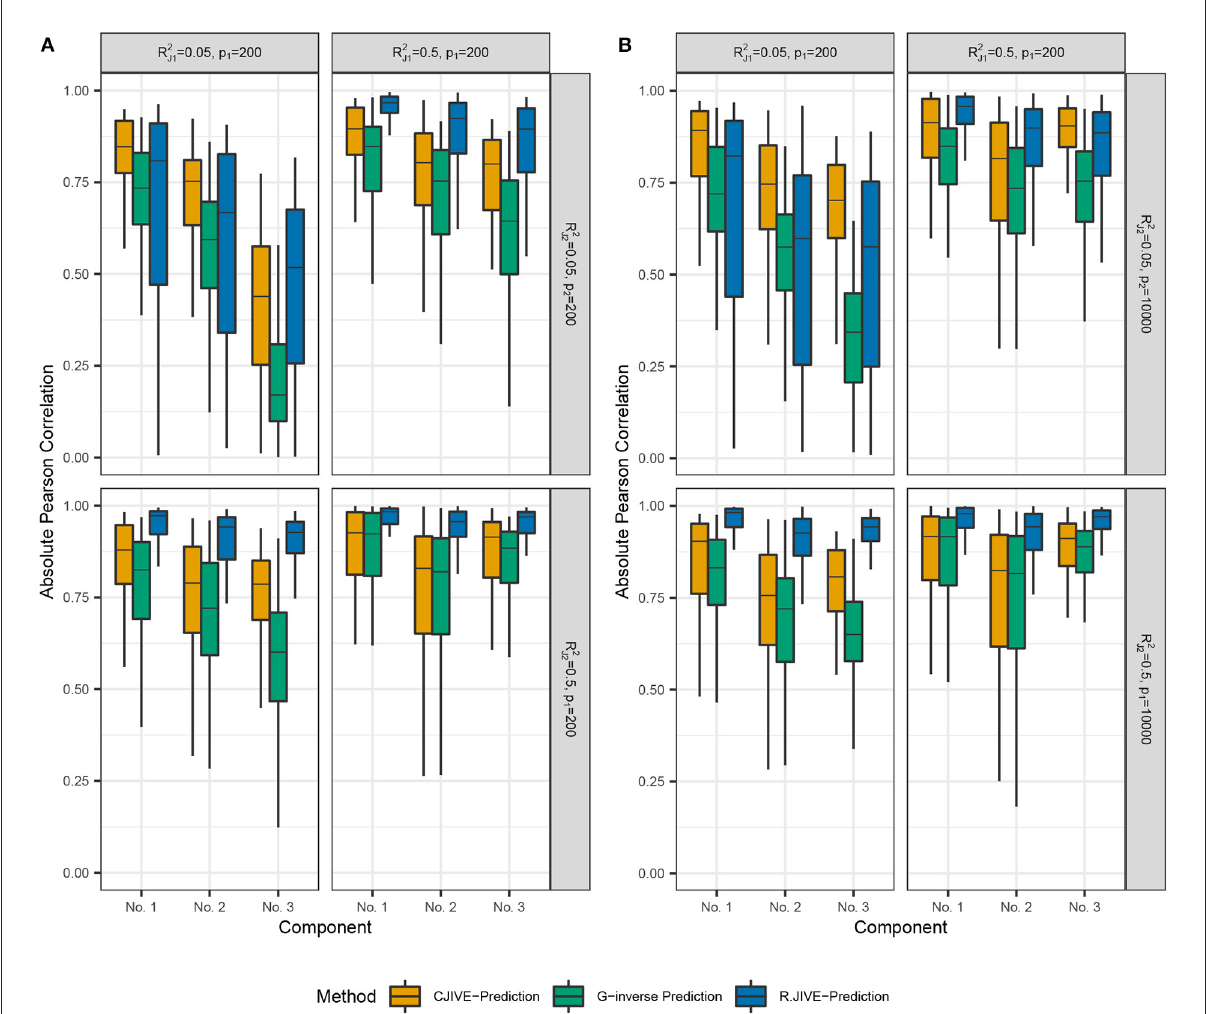
FIGURE4 Results of simulation studies: (A) p 2 200, (B) p 2 10,000. Boxplots of absolute Pearson correlations between predicted joint scores and true = = joint scores in simulation study. R 2 J 1 and R 2 J 2 represent the true joint variation controlled in simulations. We held the sample size and individual R 2 I 2 variation explained constant at n 200 and R 2 I 1 0.25, respectively. (A) shows results for p 1 = = = p 1 200, p 2 10,000. Data were simulated so that the proportion of variance attributable to the jth joint component in X k , ( k = = is given by R 2